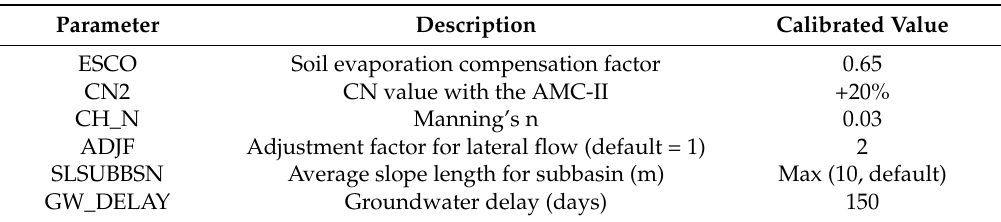
Table 2. Calibrated model